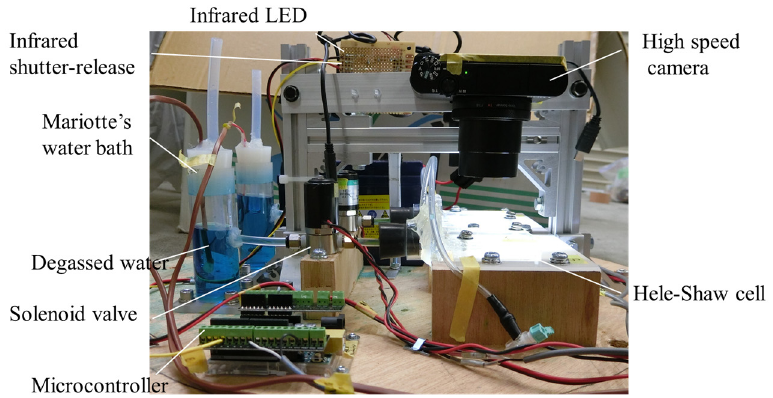
Figure 4. Experiment apparatus. Table 1. Average bulk density and porosity of 0.8 mm and 1.0 mm beads layers.